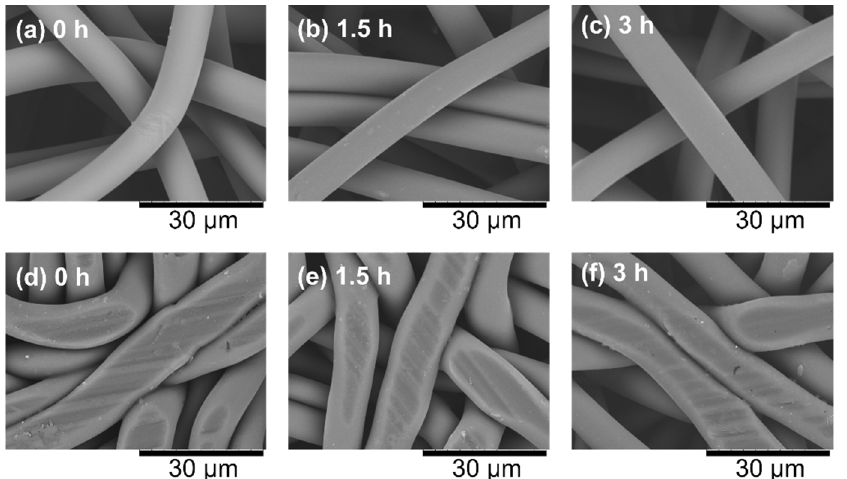
Figure 5. Scanning electron microscope images of the surface of raw nonwoven fabrics and the sample compressed to 1 mm. ( a ) Raw nonwoven fabric without heat treatment, ( b ) raw nonwoven fabric after 1.5 h heat treatment, ( c ) raw nonwoven fabric after 3 h heat treatment, ( d ) CO 2 -assisted polymer compression (CAPC) product made from untreated nonwoven fabric, ( e ) CAPC product using nonwoven fabric heated at 94 °C for 1.5 h as raw material, and ( f ) CAPC product using nonwoven fabric heated at 94 °C for 3 h as raw material.